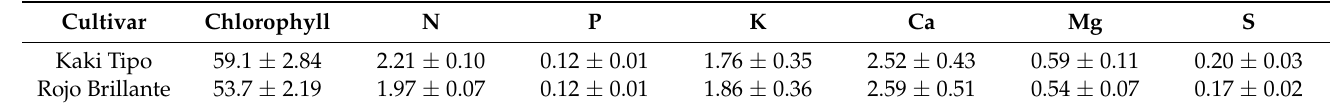
Table 1. Chlorophyll (SPAD unit) and macronutrients (g 100g − 1 DW) concentration of persimmon leaves sampled in summer (means ± SD, n = 20).